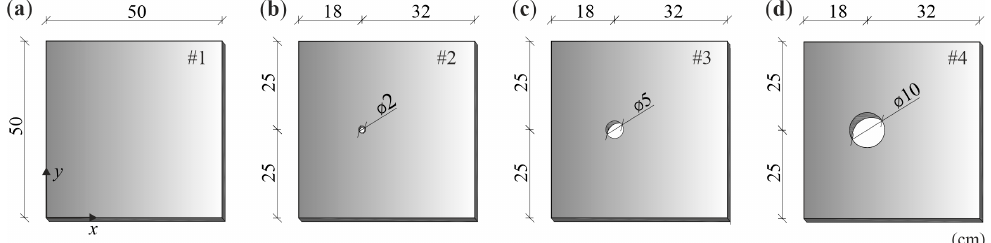
Figure 2. The geometry of the tested plates: ( a ) plate without damage (#1); ( b – d ) plates with surface damage (#2–#4).